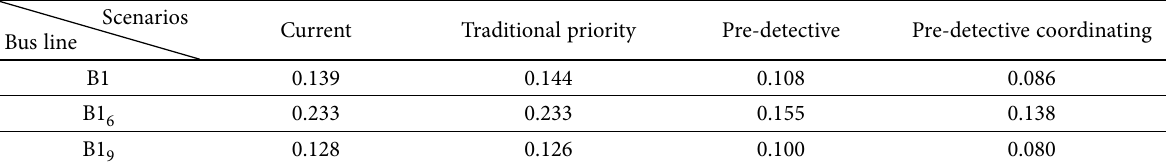
Table 3. Headway adherence